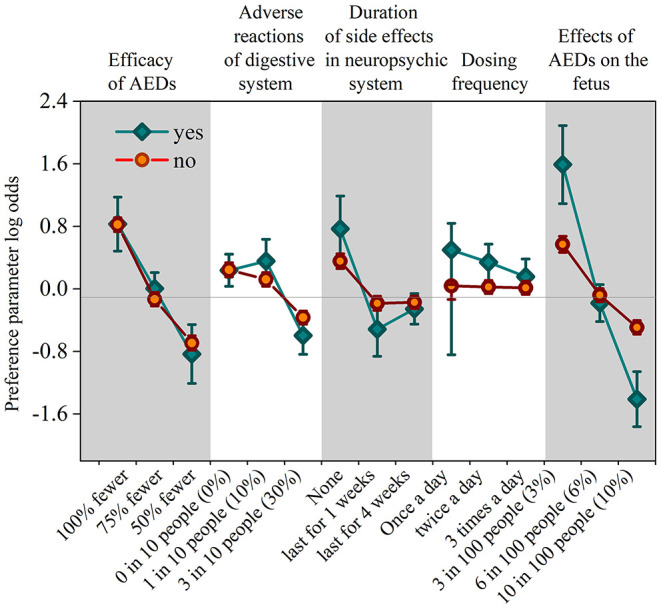
The coefficient of personal attribute in the intention for having babies. Vertical bars denote 95% confidence intervals.